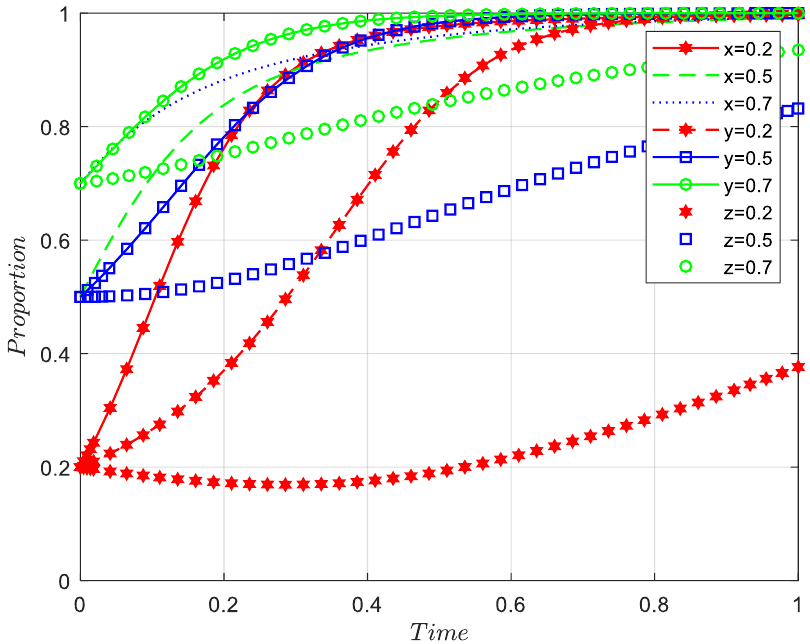
Figure 7. Government regulatory agencies–SME–consumer after public health emergencies (Two- dimensional graph).